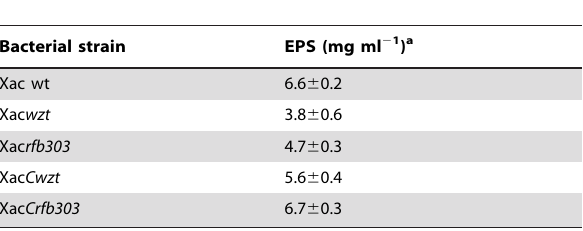
Table 2. Xanthan production in liquid medium of Xac strains.